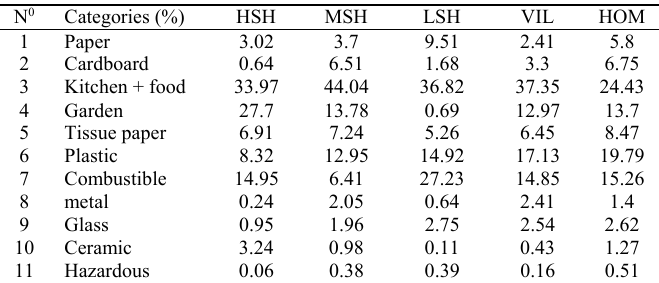
Table 5: Waste composition of 5 groups of hotels in Hoi An city